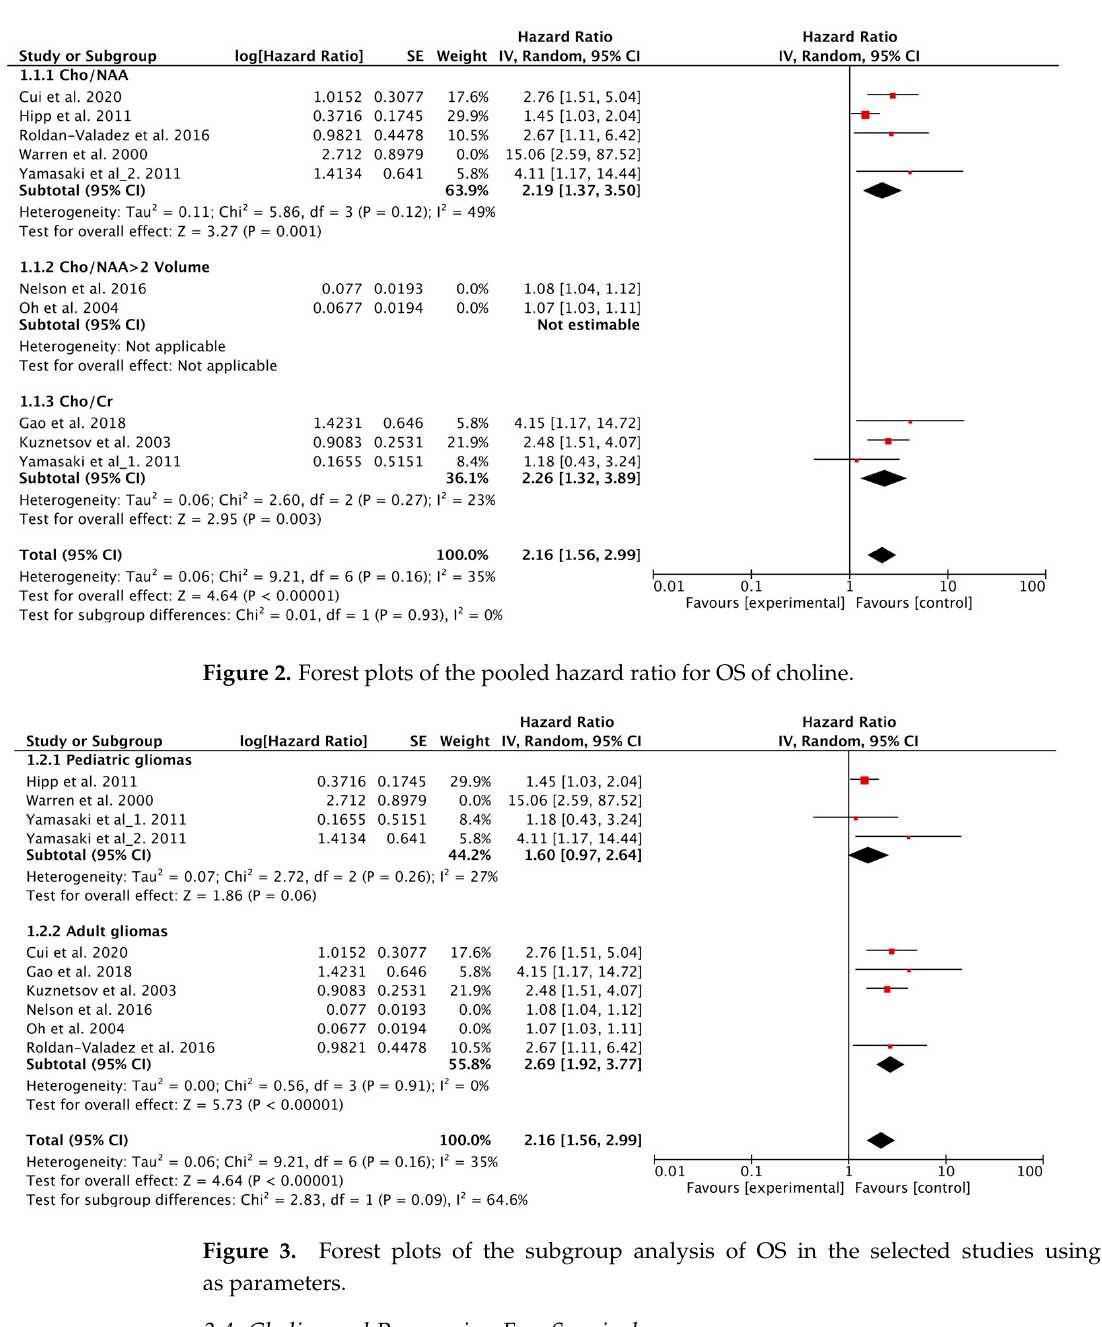
. Figure 4 . Forest plots of the pooled hazard ratio for PFS of choline. 3.5. The Prognostic Value of Other Metabolites Measured Using 1 H-MRS After excluding studies evaluating the prognostic value of Cho in gliomas, there was not enough data to conduct a meta-analysis of other metabolites, including Cr [11], lipid- lactate [14], lactate [8,9,13], myo-inositol [15], glycine [3], 2-HG [3,18], and glutamate [18]. The associations between these metabolites and prognoses are summarized in Table 3.